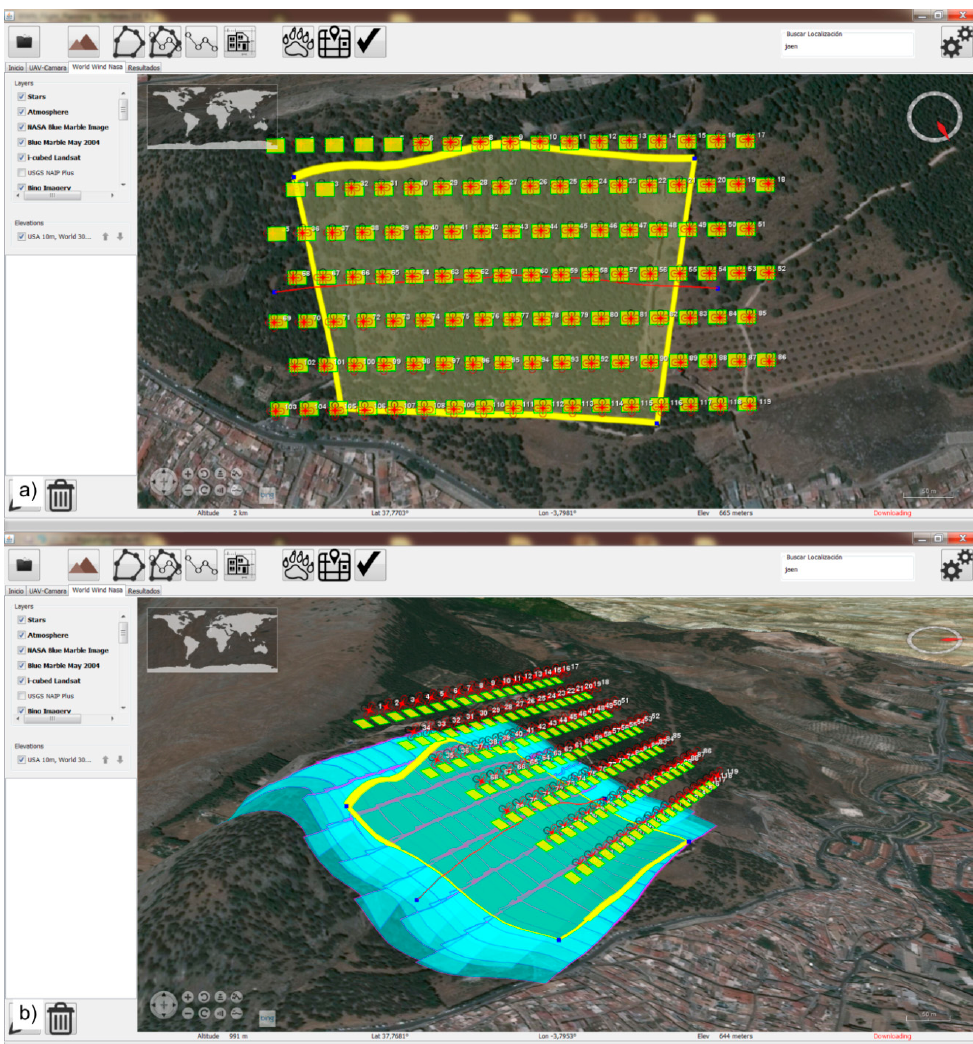
Figure 7. Example of combined flight: ( a ) block and corridor combined flight and ( b ) real footprints obtained considering the DEM.